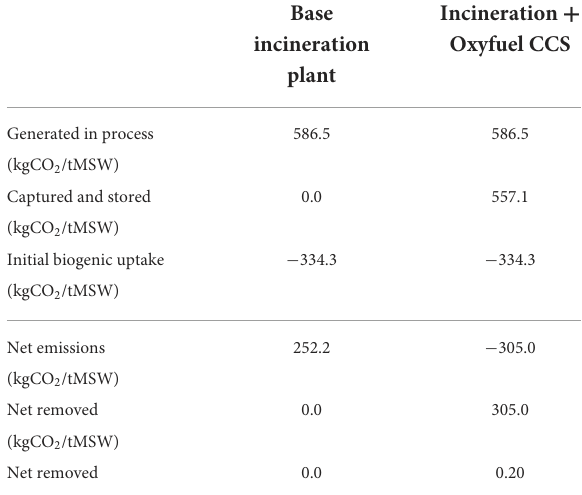
TABLE 3 Carbon balance for Case 1.